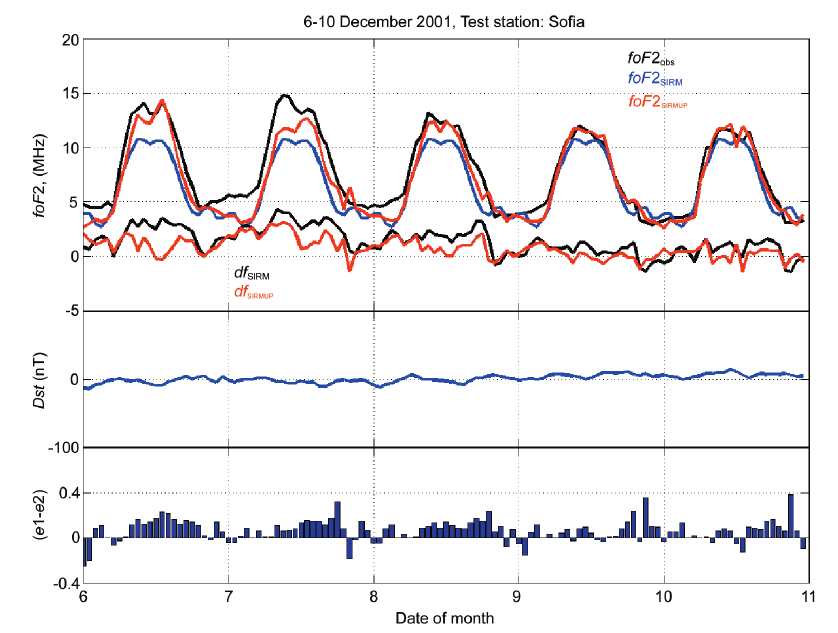
Fig. 4. Simulation results of the quiet period 6-10 December 2001 at the test station in